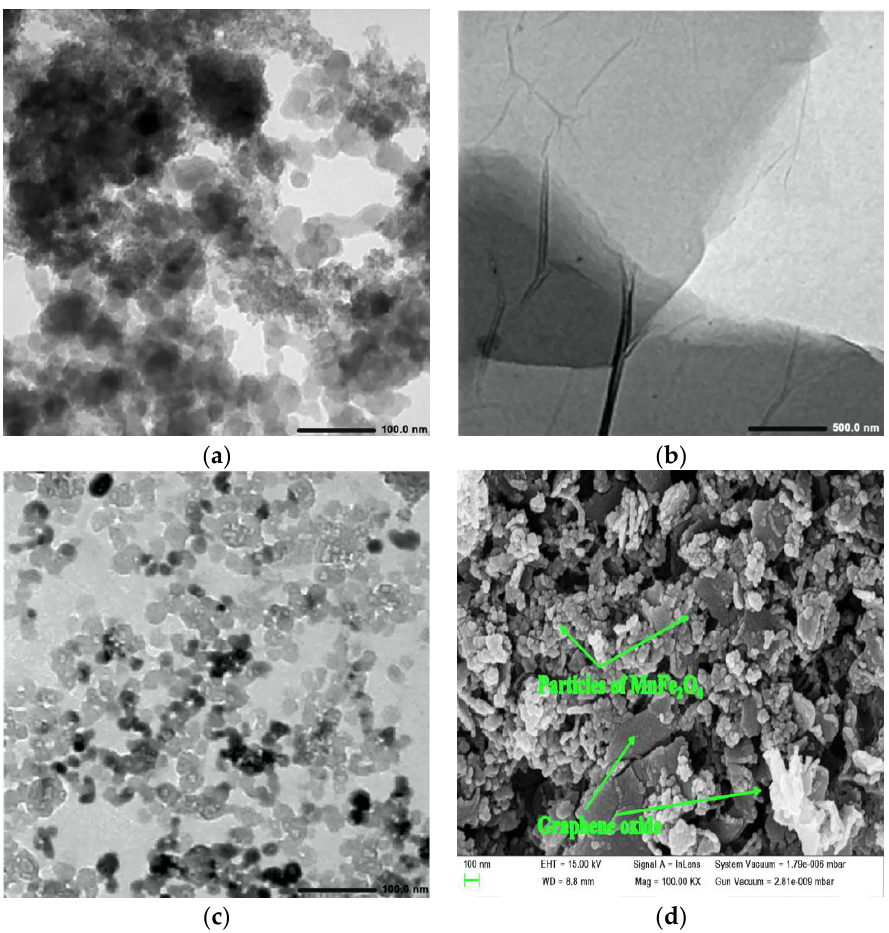
Figure 1. TEM image of MnFe 2 O 4 nanoparticles ( a ), graphene oxide ( b ), and MnFe 2 O 4 /graphene oxide nanocomposite ( c ); SEM image of MnFe 2 O 4 /graphene oxide nanocomposite ( d ).